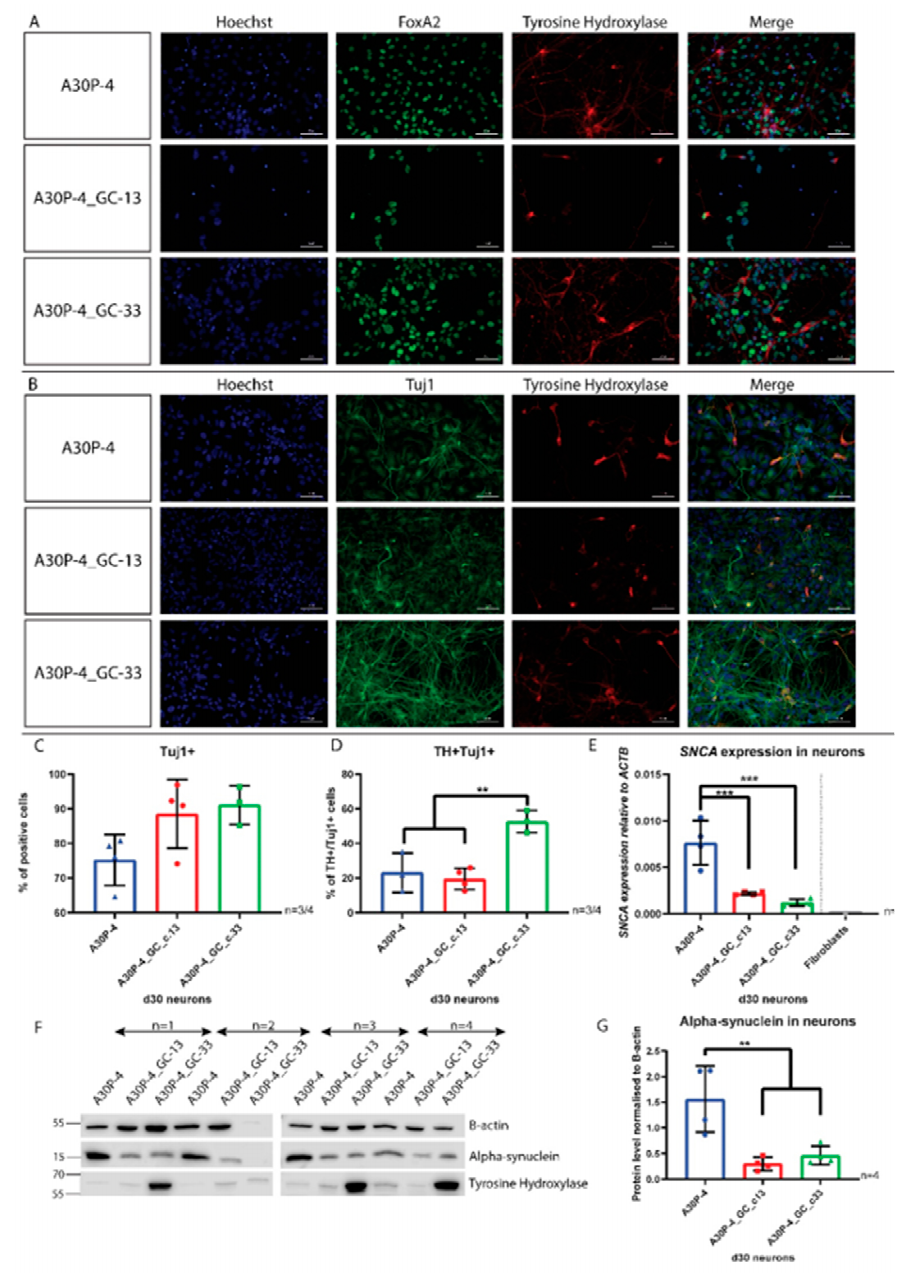
Figure 7. Characterization of vmDANs and quantification of SNCA expression and alpha-synuclein level. ( A , B ) Immunofluorescence of FOXA2, TH and TUJ1. Scale bar is 50 µM. ( C ) Quantification by flow cytometry of TUJ1 neurons ( n = 3/4), and ( D ) TH+/TUJ1+ neurons ( n = 3/4; ANOVA, ** p < 0.01). ( E ) Relative quantification of SNCA expression in vmDANs ( n = 4), (ANOVA, *** p < 0.001). ( F ) Protein immunoblot showing alpha-synuclein and TH protein level in vmDANs. ( G ) Quantification of alpha-synuclein protein ( n = 4; ANOVA, ** p < 0.01). For all statistical analyses, ordinary one-way ANOVA’s were performed using the Tukey post hoc multiple comparison test.